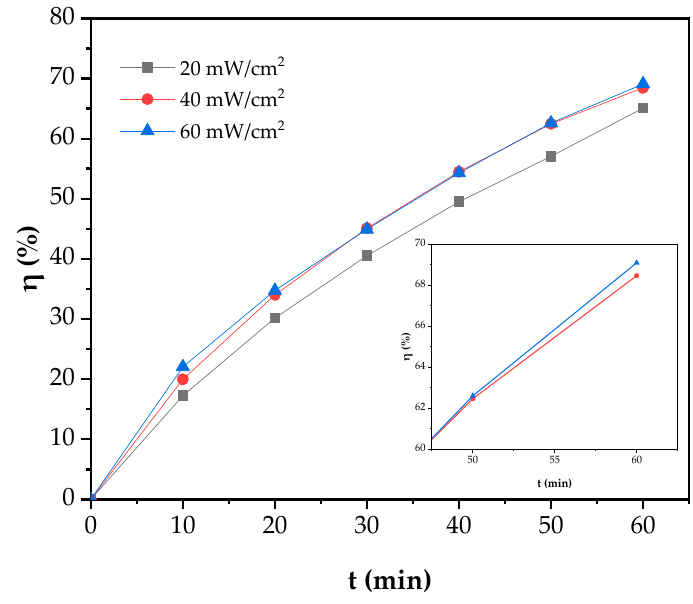
Figure 7. Effect of UV irradiation intensity on Cu removal efficiency through photochemical Figure 7. E ff ect of UV irradiation intensity on Cu removal e ffi ciency through photochemical process.